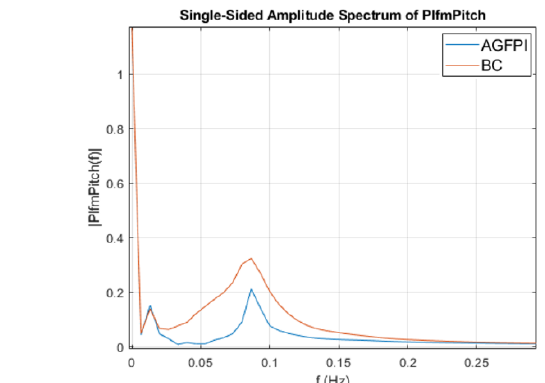
Figure 6. Output power without waves.